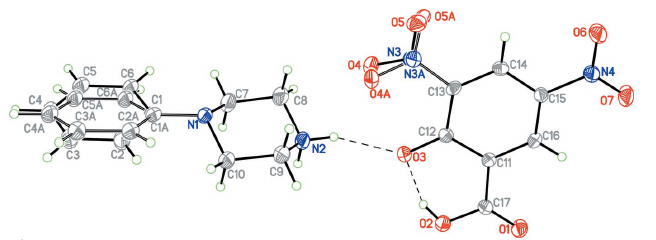
Figure 5 The molecular structure of 6 with hydrogen bonds shown as dashed lines and disorder of the phenyl ring and one nitro group indicated. Atomic displacement parameters are at the 30% probability level.